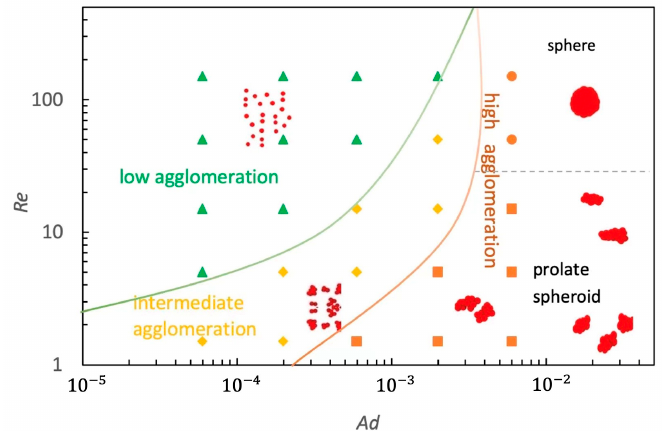
Figure 6. Agglomeration regime map for the DMT model. Phase diagram illustrating the observed cases as a function of the Reynolds and adhesion numbers at a solid particle volume fraction 4.2%.